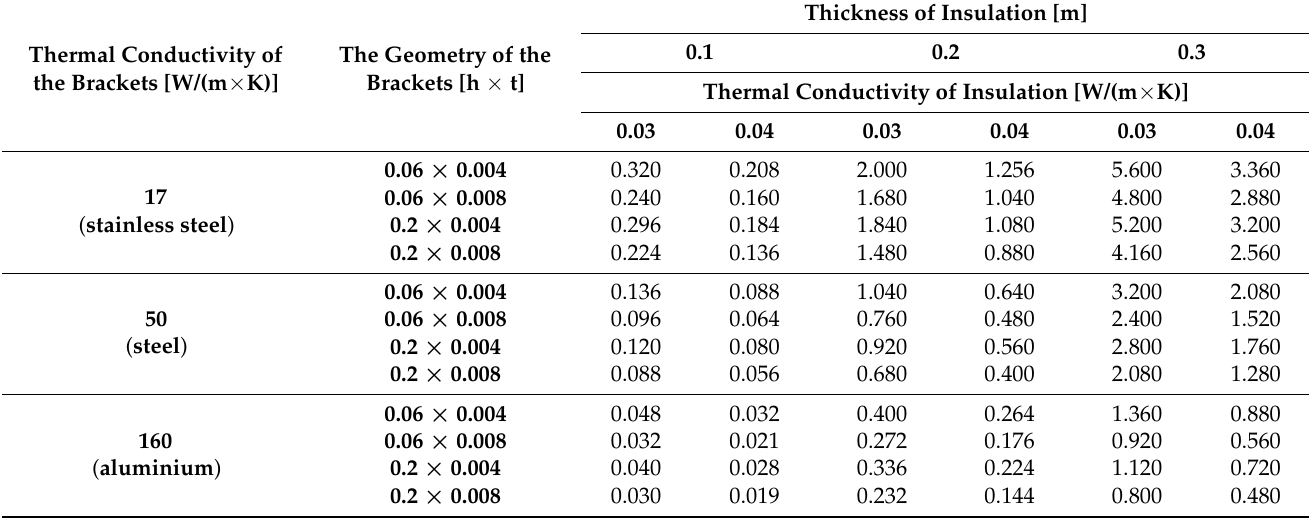
Table 5. “ α ” multiplication correction factors for reinforced concrete wall.